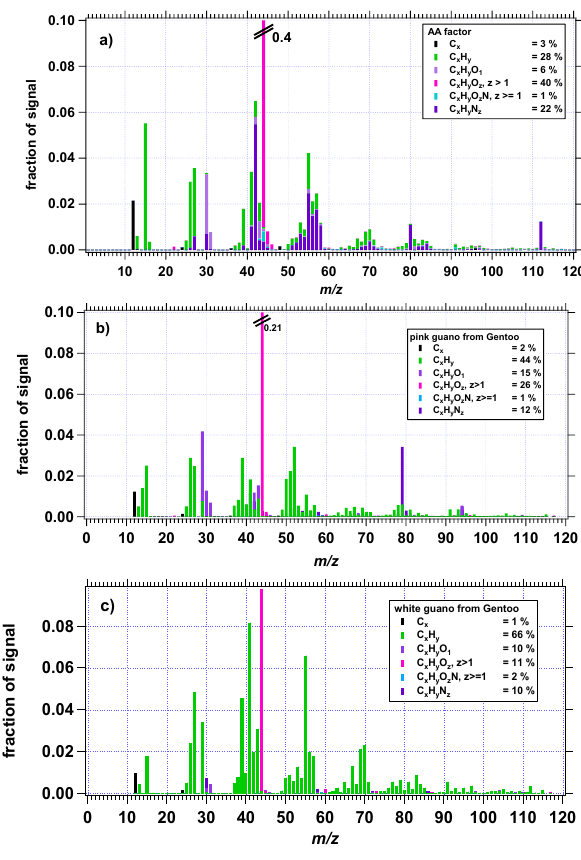
Fig. 14. Speciated organic mass spectrum of the amino acid/amine PMF factor (a) , pink guano from gentoo (b) and white guano from gentoo (c) . The percentages in the legend indicate the mass contri- bution to the total organic matter